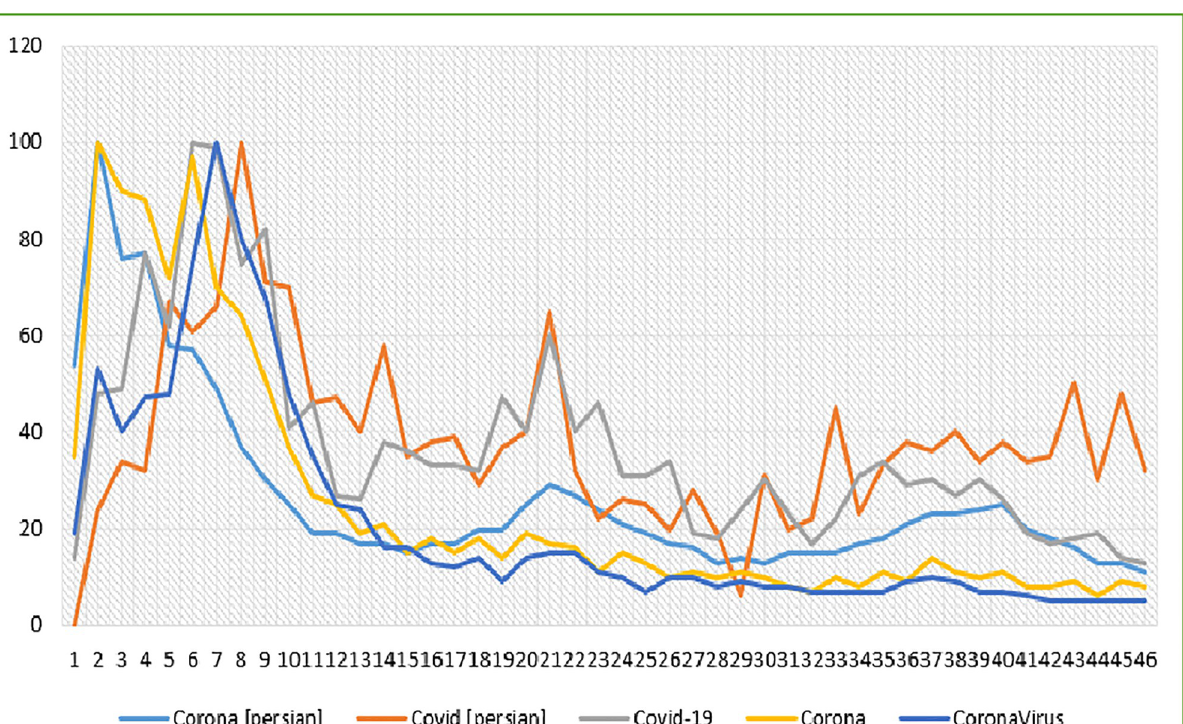
Fig 1. Search interest for COVID-19 related terms in weekly periods from 16 Feb 2020 to 2 Jan 2021.